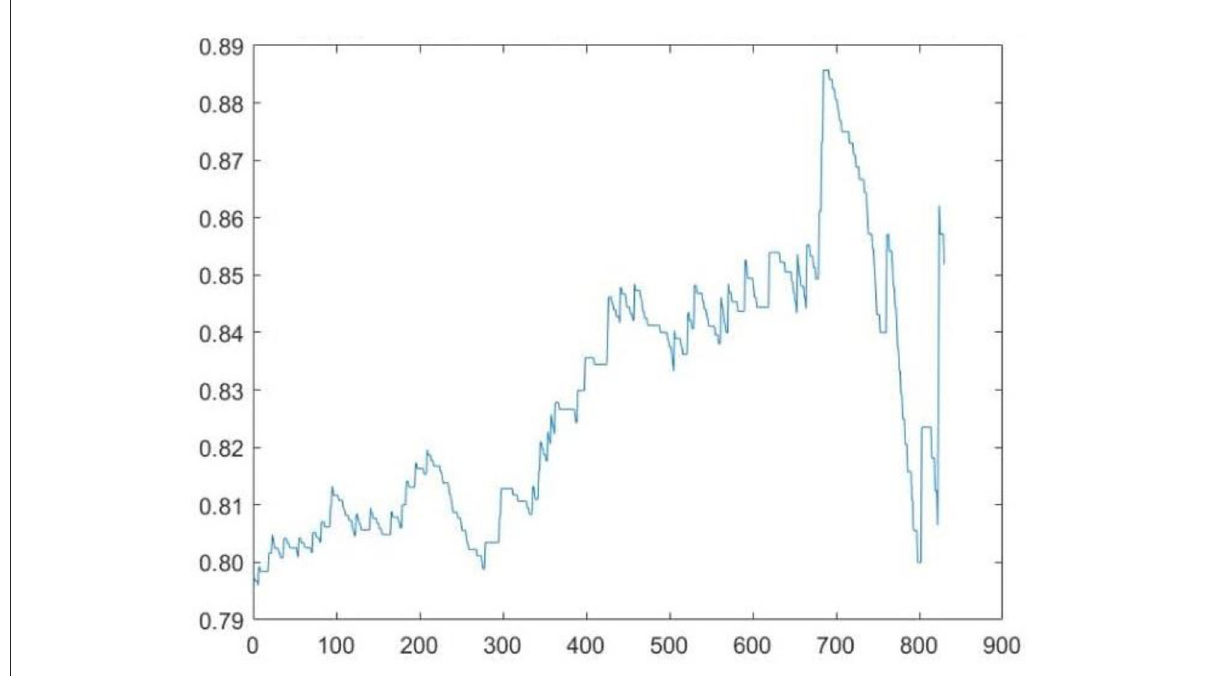
FIGURE1 A dynamic diagram of upper- tail-dependence coefficients statistics.